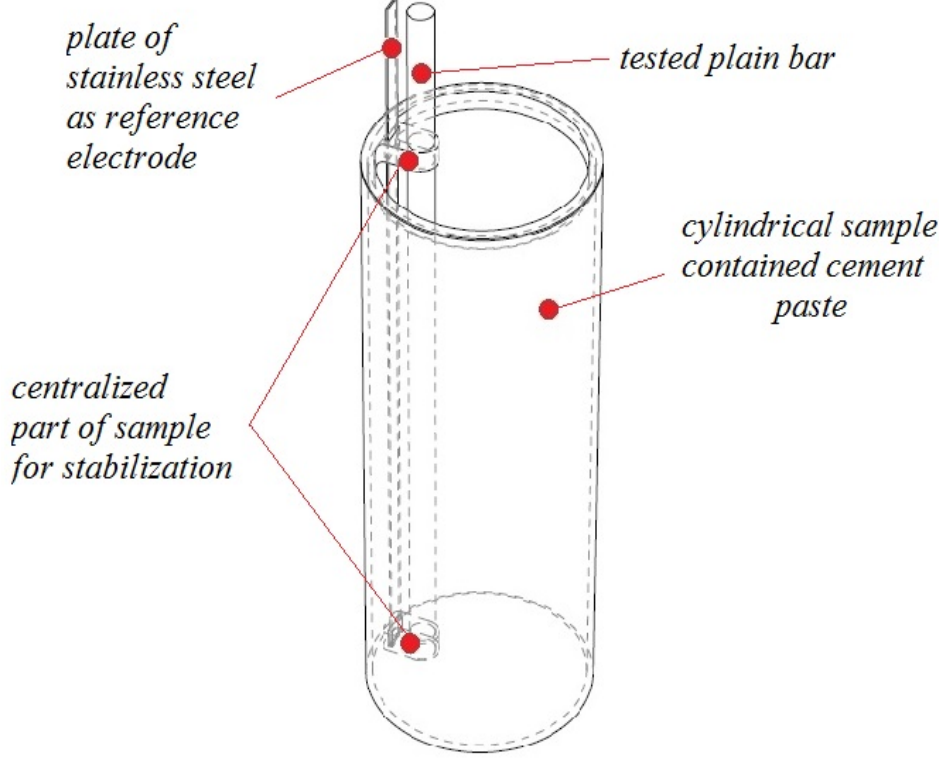
Figure 1. Modeling of samples designed for measurements during E corr /FeCr18Ni9 and bond strength of hot-dip galvanized plain bars in cement paste.